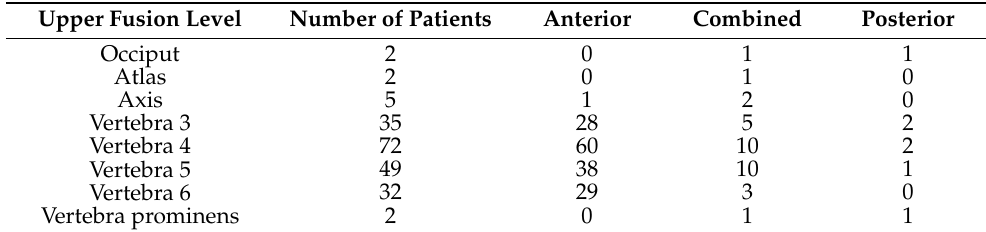
Table 3. Upper fusion levels and surgical approaches. Upper Fusion Level